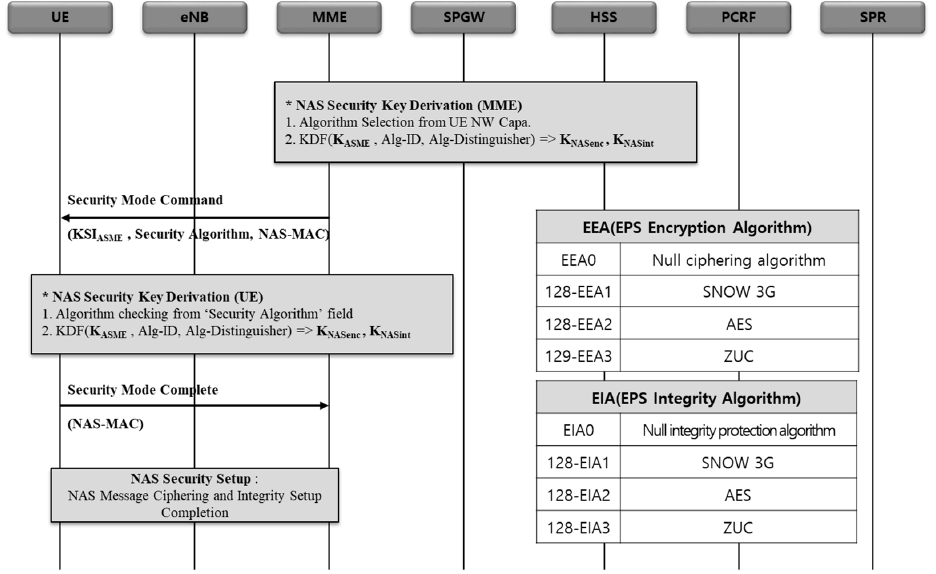
Figure 3. NAS security setup procedure of 5G